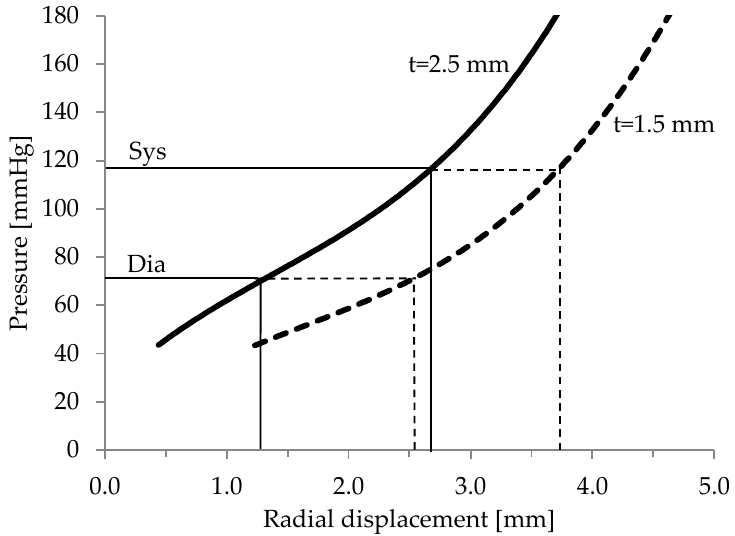
Figure 3. Radial displacement of node in aortic wall centre is plotted against the ramped inner wall pressure for t = 1.5 and t = 2.5 mm. Systolic (Sys) and diastolic pressure (Dia) of the pulse pressure wave are marked with horizontal lines.